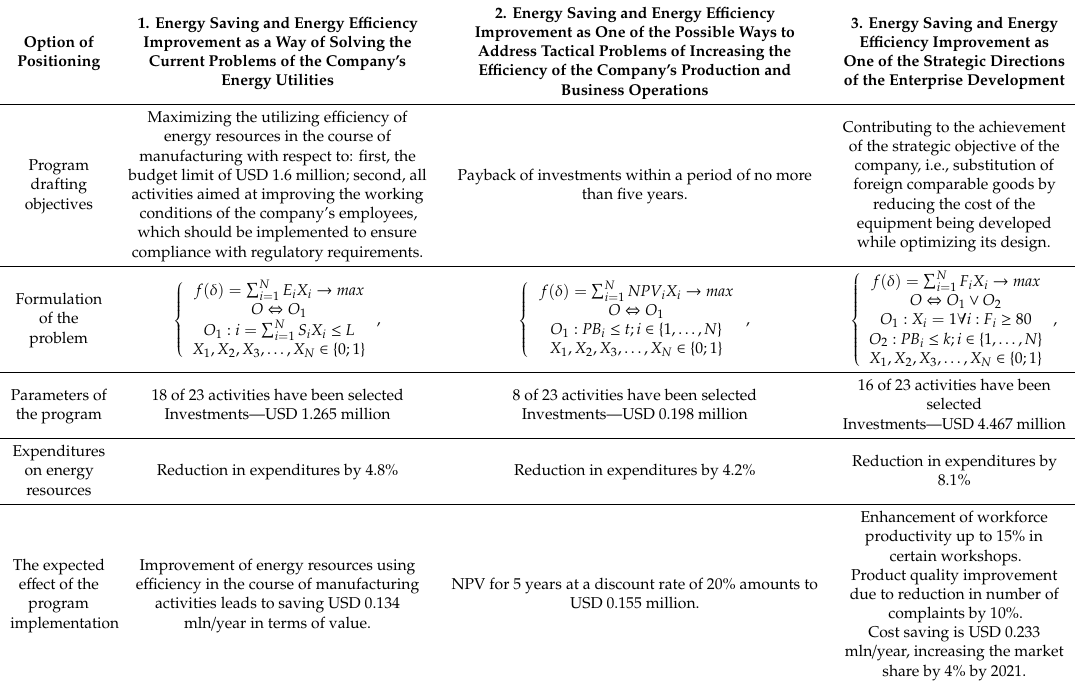
Table 4. The optimization results of energy saving and energy e ffi ciency improvement program under various positioning options (source: compiled by the